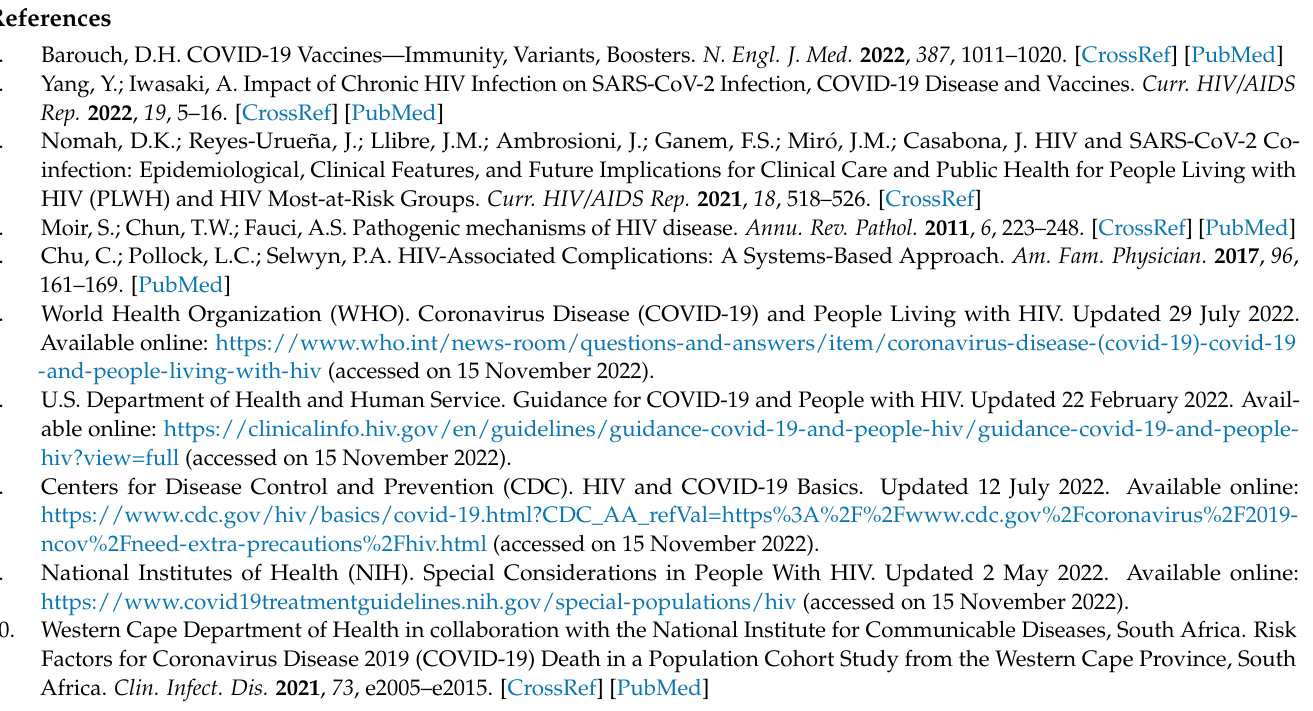
Figure S2. Gating strategy for the identification of the SARS-CoV-2-specific T cells; Figure S3. Gating strategy for the identification of the spike-specific B